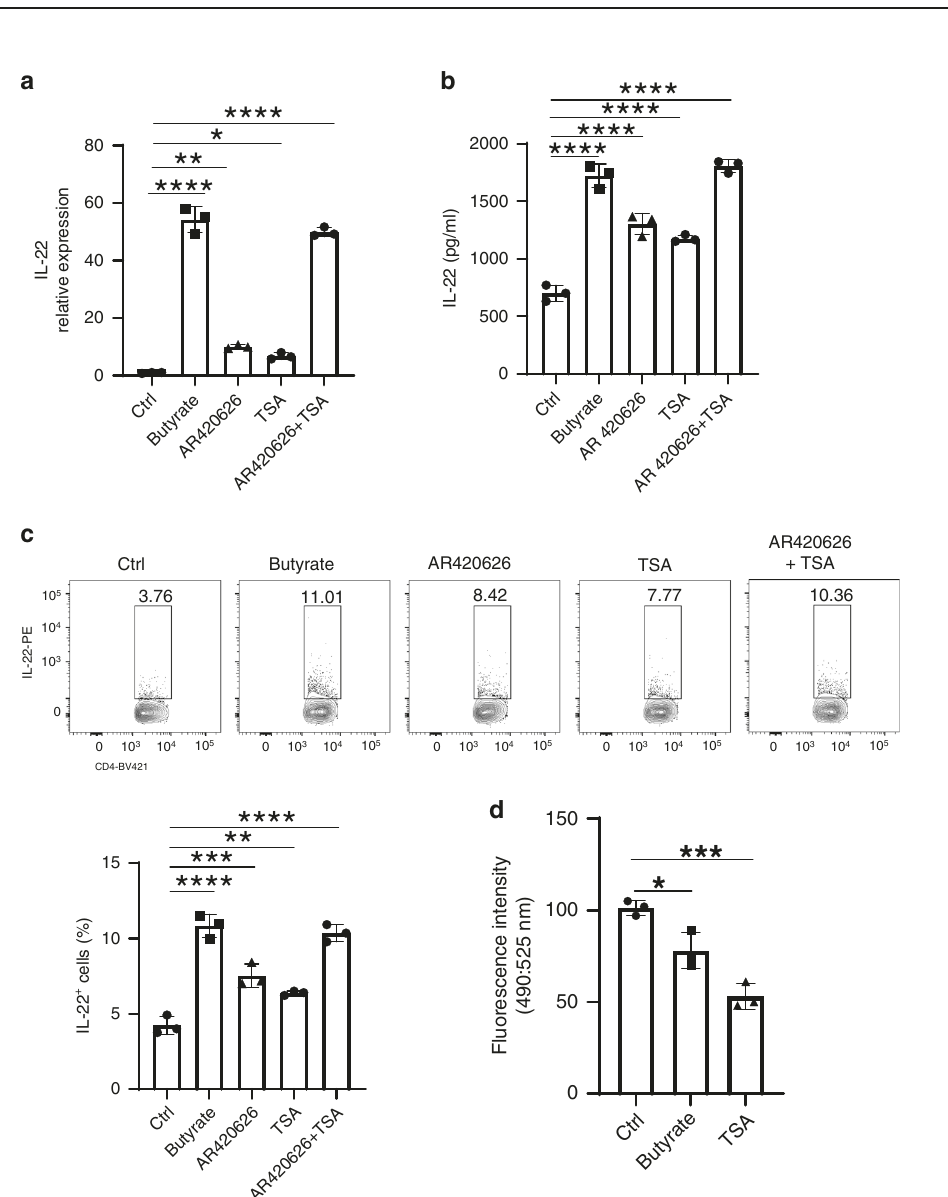
Fig. 2 Butyrate promotes intestinal CD4 + T cell and ILC production of IL-22. WT mice were treated with or without 200 mM butyrate in drinking water for 3 weeks ( n = 4 mice/group). a Mice were weighed daily. b Fecal pellets were collected prior and after 3-week treatment of butyrate, and butyrate levels were measured by LC – MS. Mice were killed on day 21, and IL-22 production in serum ( c ) and colonic organ cultures ( d ) were measured by ELISA. IL-22 production in CD4 + T cells ( e ) and ILCs ( g ) were analyzed in the spleen, MLN, and intestinal LP by fl ow cytometry. IL-22 levels in Th1, Th17, Treg cells ( f ), and ILCs ( h ) were measured in intestinal LP by fl ow cytometry. One representative of three independent experiments was shown. Data were expressed as mean ± SD. Statistical signi fi cance was tested by two-tailed unpaired Student t -test. b *** p = 0.0009; c * p = 0.0145; d * p = 0.0393; e middle panel: * p = 0.0158 (SP), 0.0151 (MLN), and 0.0022 (LP); right panel: * p = 0.0359 (SP), 0.0377 (MLN), and 0.0481 (LP); f middle panel: * p = 0.0356 (Th1) and 0.0375 (Th17); right panel: * p = 0.0432 (Th1) and 0.0158 (Th17); g middle panel: * p = 0.0149 (SP), 0.0227 (MLN), and 0.0232 (LP); right panel: * p = 0.0126 (SP), 0.0448 (MLN), and 0.0462 (LP); h middle panel: * p = 0.0458; right panel: * p = 0.0436.